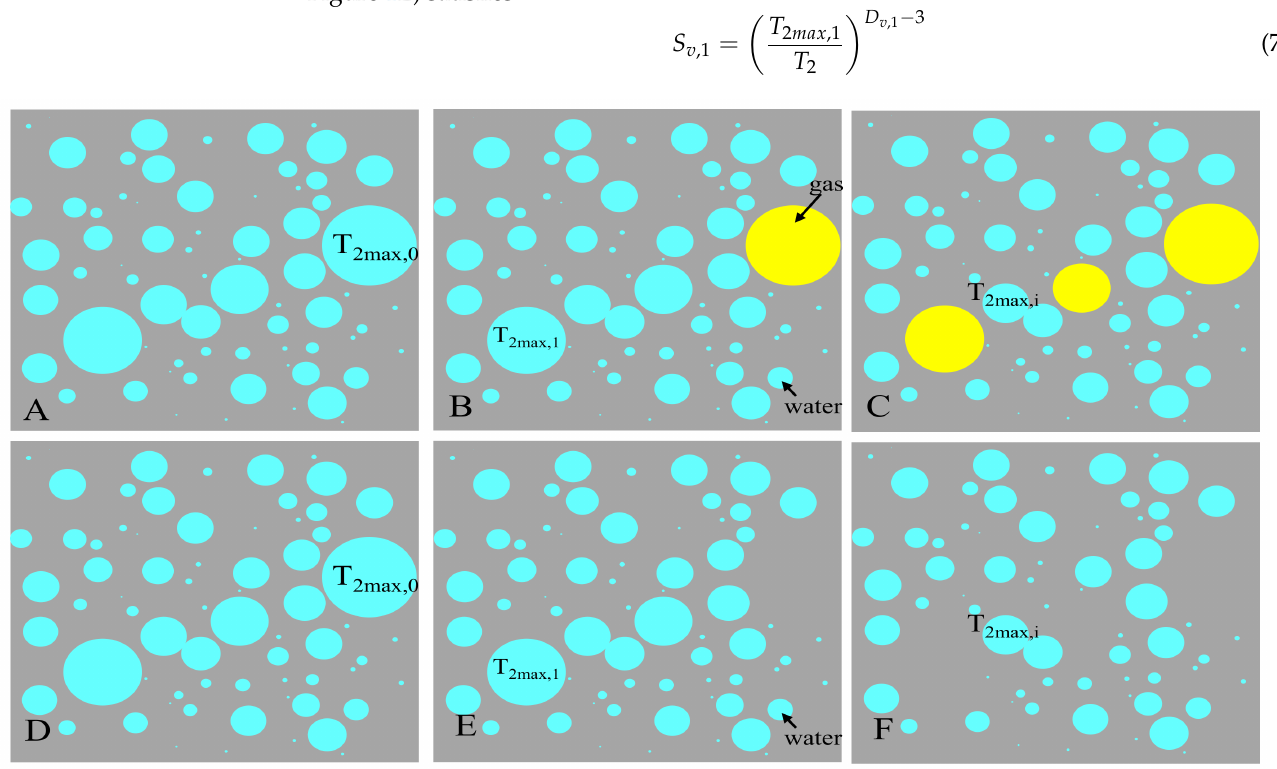
Figure 1. Influence of gas filling on pore structure from NMR. ( A ) Water-saturated rock; ( D ) Equiv- alent pore structure model of ( A ) from NMR; ( B ) The maximum pore in ( A ) is filling with gas; ( E ) Equivalent pore structure model of ( B ) from NMR; ( C ) Gas filling in the pores bigger than the ( i − 1)-th largest pore; ( F ) Equivalent pore structure model of ( C ) from